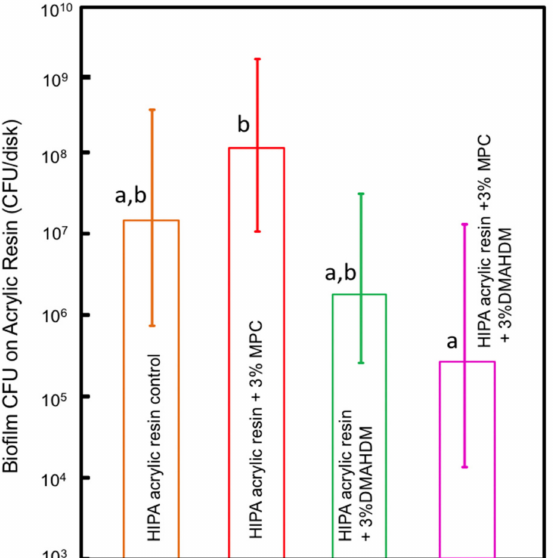
Figure 5. Acrylic resin biofilm colony-forming units; similar letters indicate statistical similarity (Tukey’s test, p <